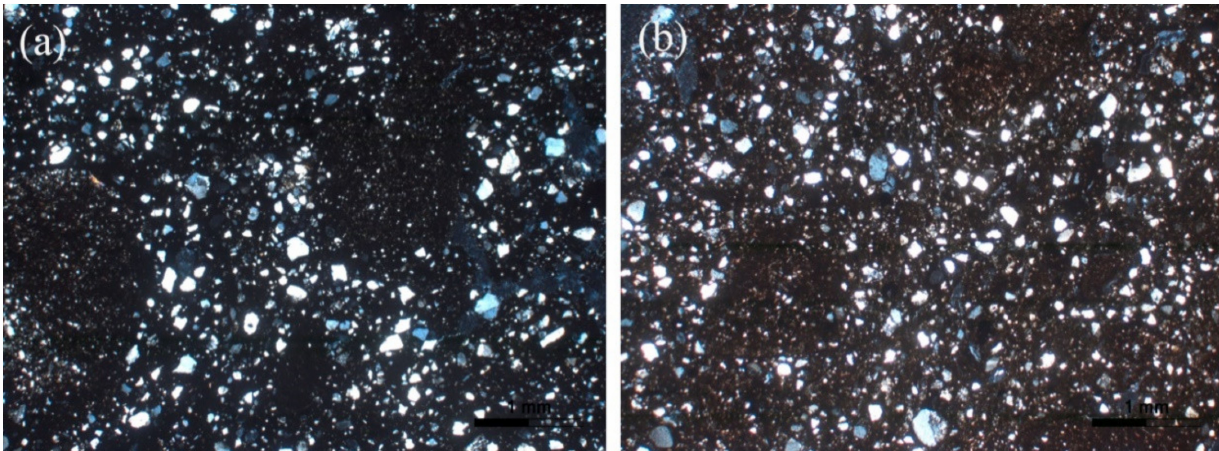
Figure 4. Representative photomicrographs of group 2: ( a ) sample K3 and ( b ) sample K126. All photomicrographs are taken under crossed Nicols